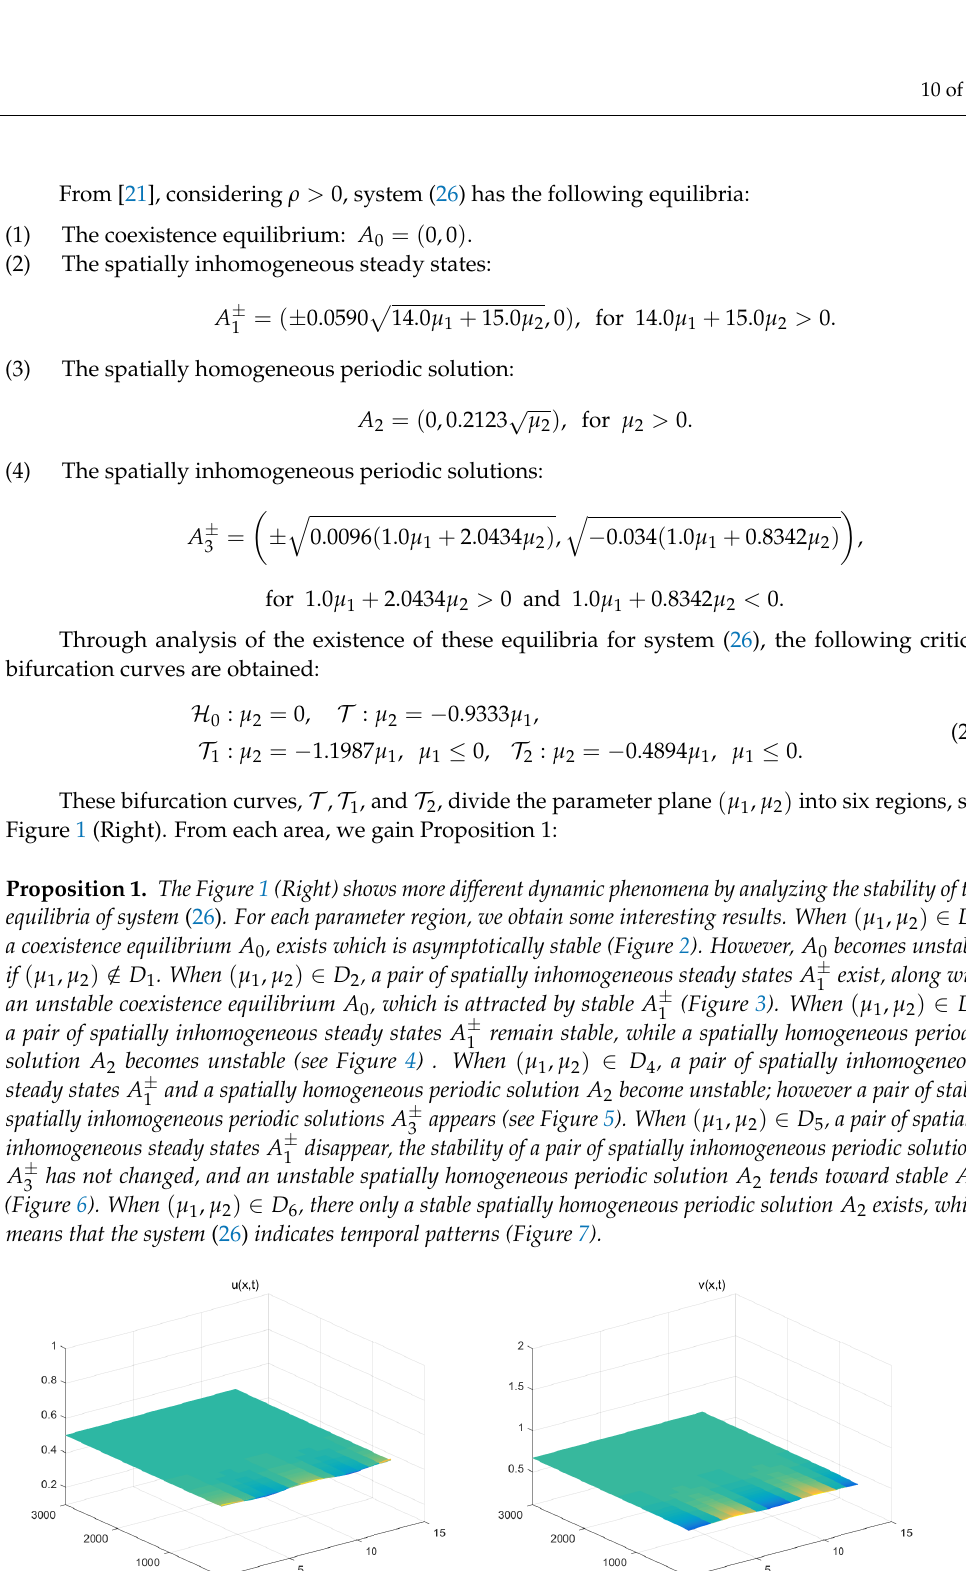
Figure 2. For ( µ 1 , µ 2 ) = ( asymptotically